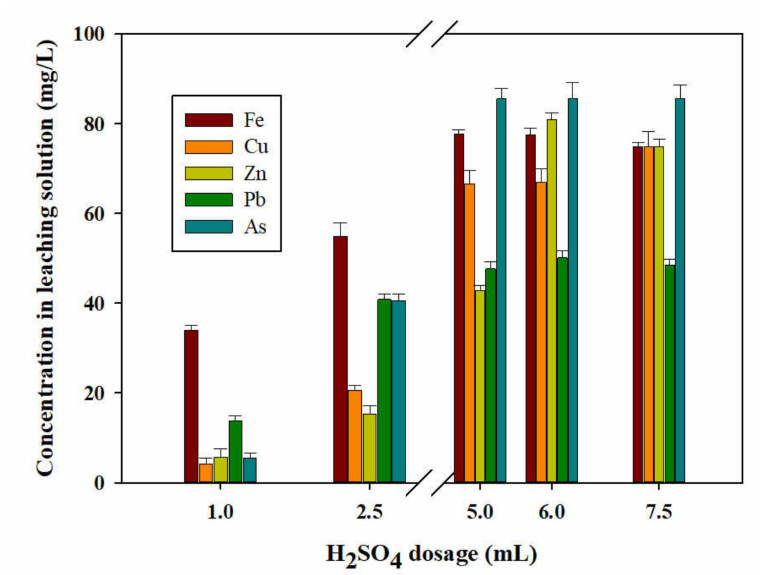
Figure 9. Effect of H 2 SO 4 dosage (1.0, 2.5, 5.0, 6.0, and 7.5 mL) in hot water leaching on leaching rate of valuable metals and As from the acid-baked gold concentrate (at 400 ◦ C, for 3 h). Arsenic removal and an enrichment in Au/Ag grade were also found in the solid residue. Insoluble solid residue was collected after the 70 ◦ C water-leaching experiment was conducted with the baked samples with H 2 SO 4 concentration. The aqua regia digestion was conducted with the solid residue, and the contents of As, Au, and Ag between the solid residue and gold concentration sample were compared (Figure 9). In Figure 10, the As removal increased with an increase in H 2 SO 4 concentration. However, the As removals at 5.0 mL, 6.0 mL, and 7.5 mL concentrations were 88.41%, 88.60%, and 88.49%, respectively. In Figure 10, the Au and Ag grade enrichments reached a maximum level (11.83% and 11.31%, respectively) at 5.0 mL H 2 SO 4 . Since the As removal and Au and Ag enrichments increased insignificantly at 5.0 mL in higher H 2 SO 4 concentrations, the optimum concentration of H 2 SO 4 was set to 5.0 mL. Subsequently, H 2 SO 4 dosage was fixed at 5.0 mL to conduct the next baking experiment at 400 ◦ C according to time.